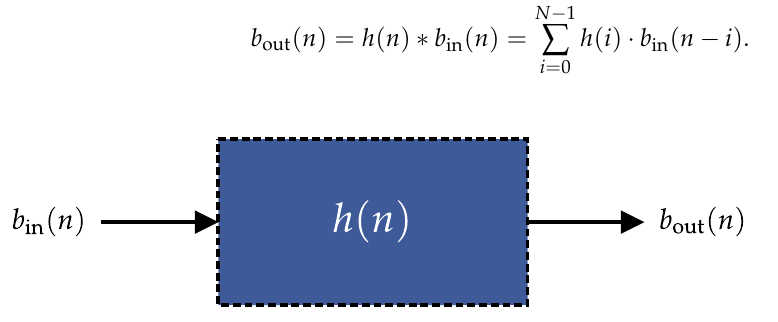
Figure 4. Biomagnetic LTI sensor system with impulse response h ( n )